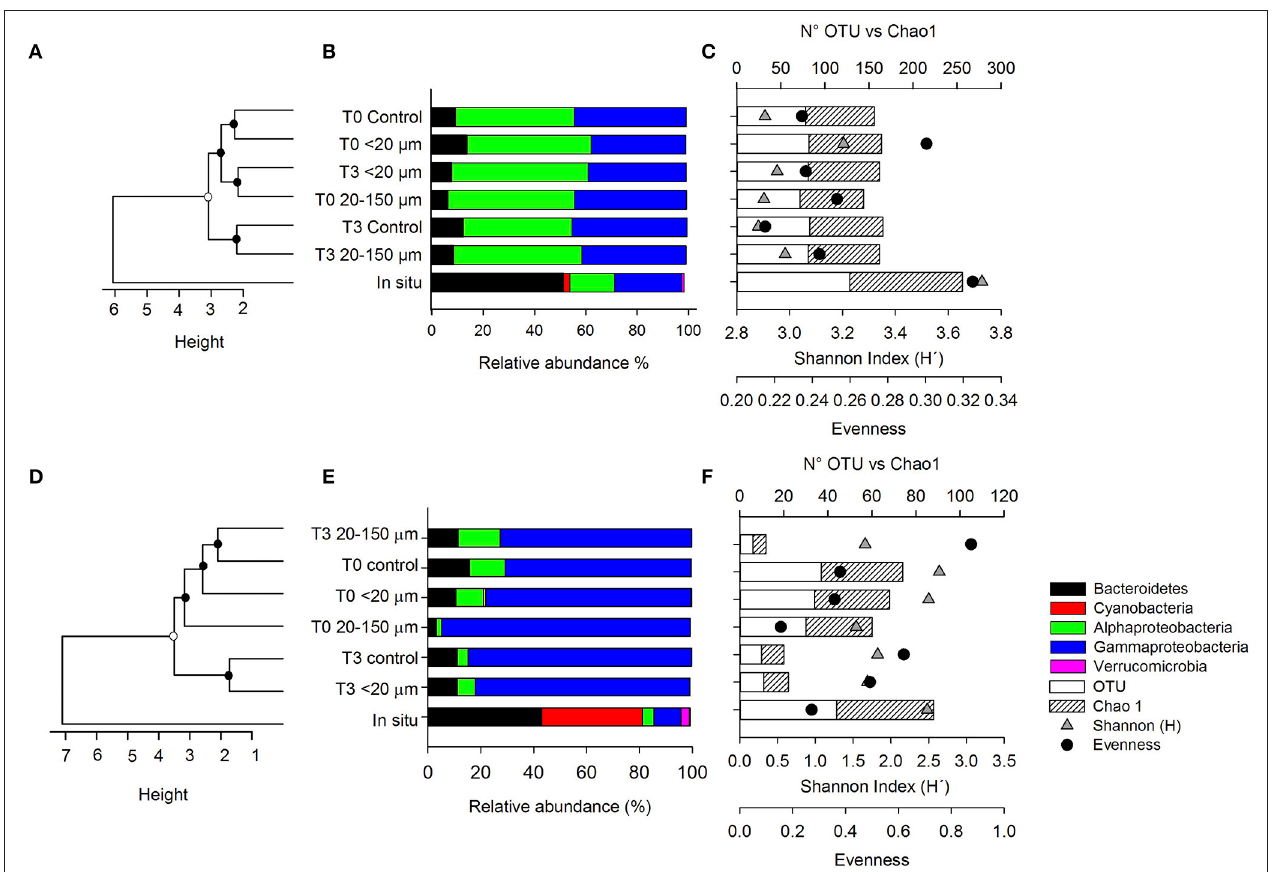
FIGURE 6 | (A–D) Unweighted Pair Group Method with Arithmetic mean (UPGMA) clustering of the bacteria community structure in late summer and spring. Bootstrap values obtained from 1,000 interactions are depicted as circles on nodes (black: > 80% and white: < 70%), (B–E) taxonomic composition of abundant ( > 0.5%) phyla and Proteobacteria classes, comparing treatments and controls in late summer and spring, respectively and (C–F) the richness, coverage of specific libraries, Shannon (H’) index, and evenness in the late summer and spring